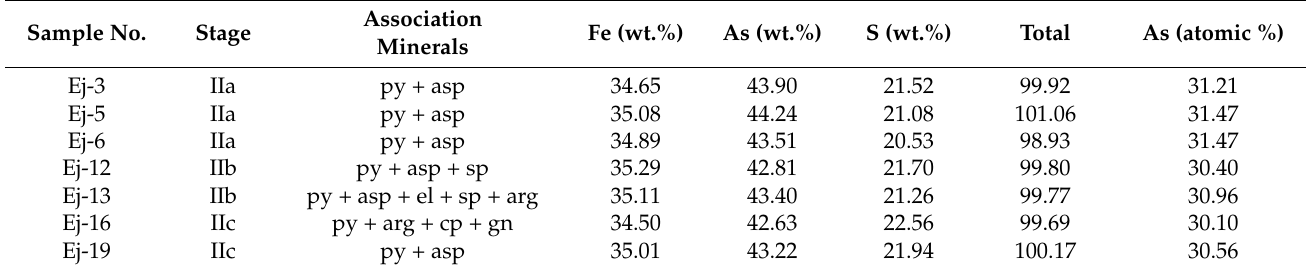
Table 3. EPMA data of stage II arsenopyrites from the Eunjeok Au–Ag deposit. Sample No.